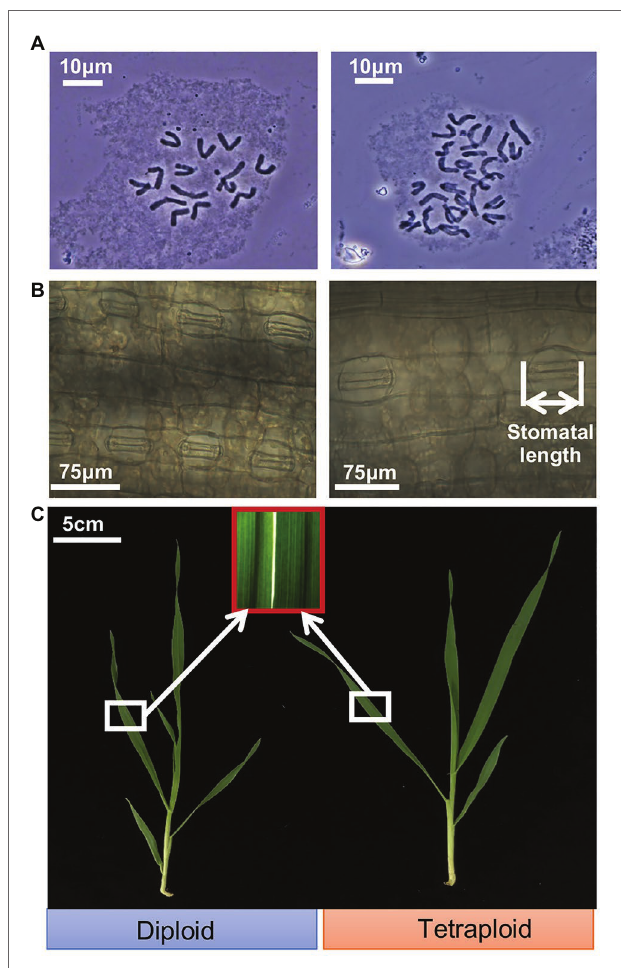
FIGURE 1 | Ploidy analysis and appearance of shoots of the diploid and tetraploid barley seedlings. (A) Chromosomes of the diploid (2 n = 14) and tetraploid (2 n = 28) barley at mitotic metaphase. (B) Closed stomas and straightened stomatal guard cells. (C) Shoots of the diploid and tetraploid barley seedlings.